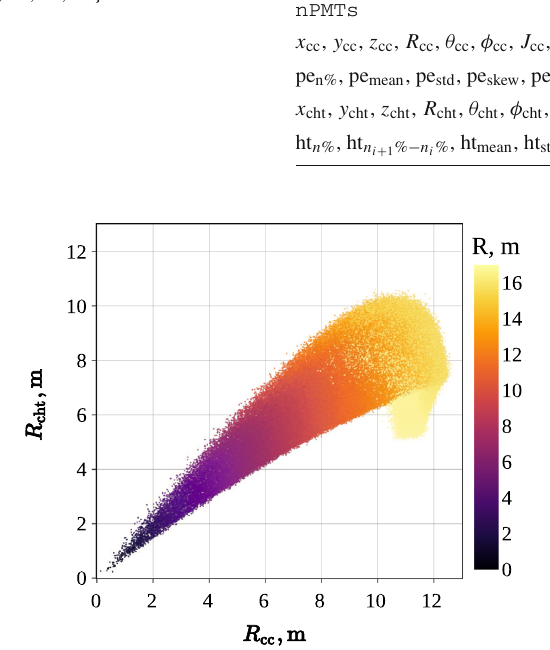
Fig. 6 Correlation between R cc and R cht and the corresponding values of the radial component of energy deposition R represented in color